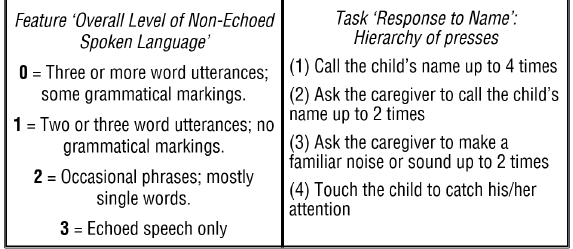
Figure 1: A simplified example of a feature (left) and task (right) from Module 2 of the ADOS-2. Coding schemes on different features possess variable levels of subjectivity (the one shown being highly objective). Hierarchies of presses are traversed sequentially until the desired child behavior is observed. (Figure adapted from [5],